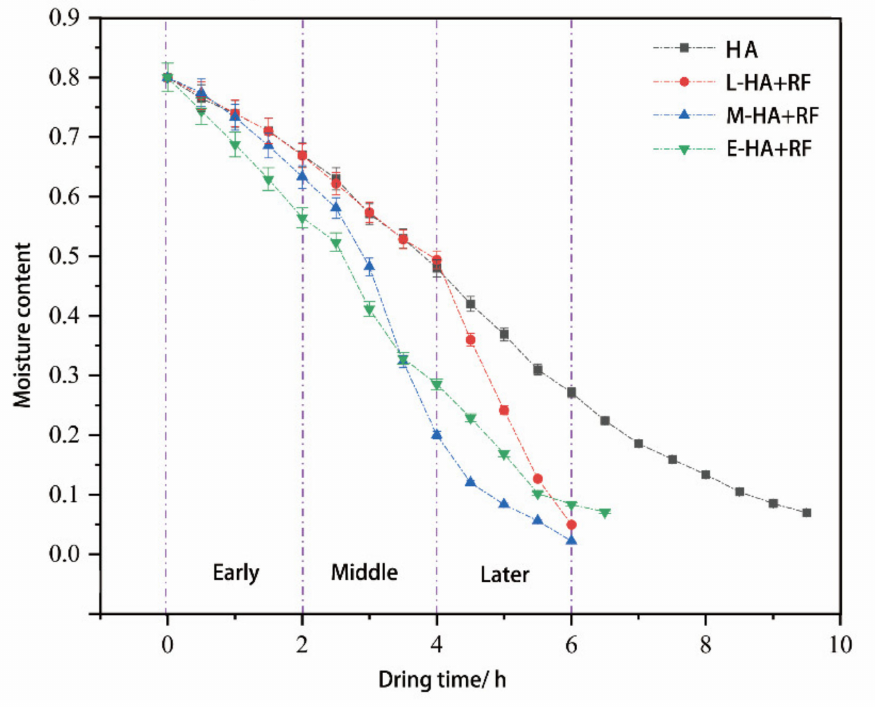
Figure 5. Drying rate of jujube slices at different drying